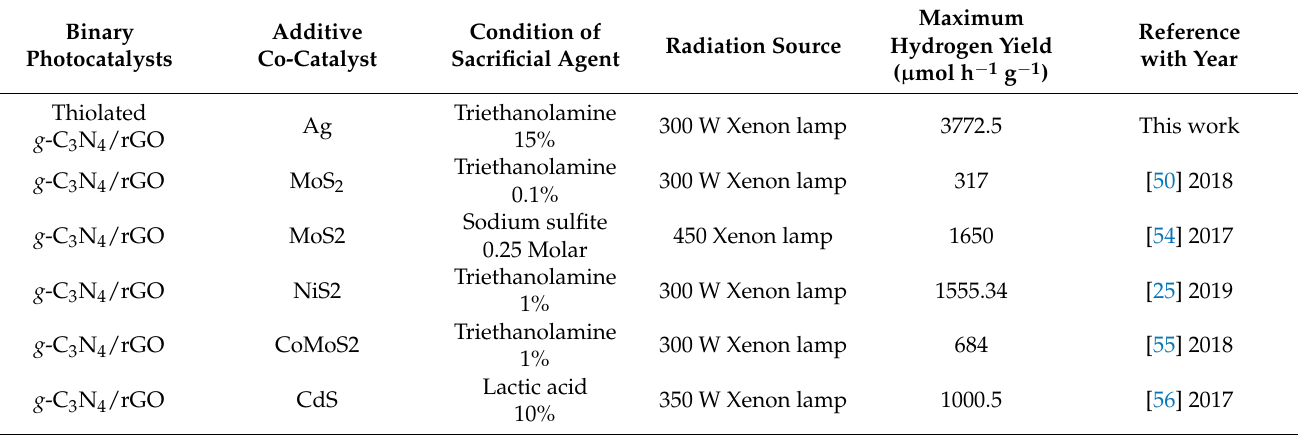
Table 1. Ternary composites of g -C 3 N 4 /rGO is better than binary composites for photocatalytic hydrogen production.